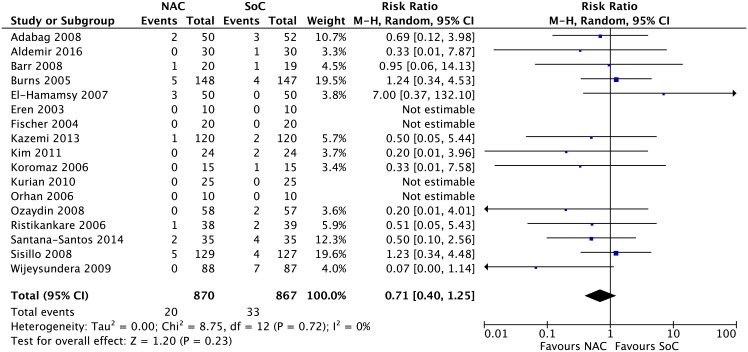
Meta-analysis on mortality.